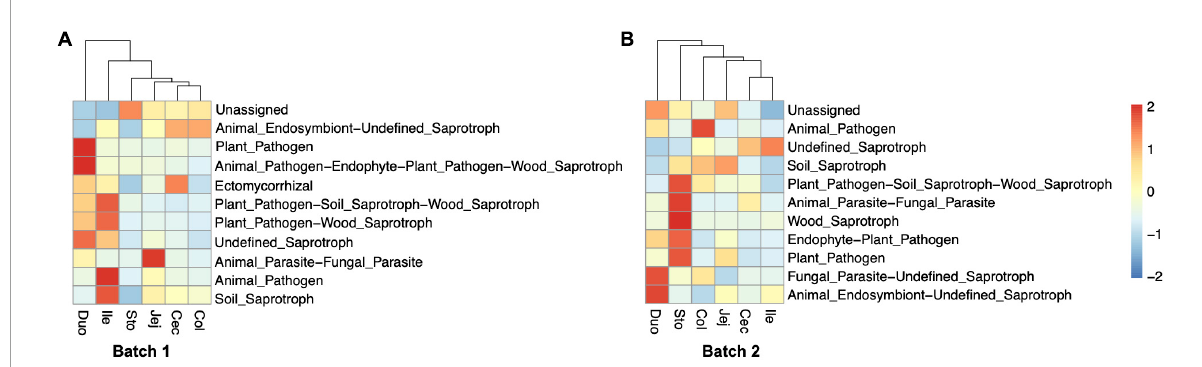
FIGURE6 Functional prediction of fungal community in different regions of the gastrointestinal tract in the pigs. Heatmap representing the relative abundance of predicted fungal functional guilds. Trophic guild assignments for fungal sequences were analyzed based on the FUNGuild database. (A) Bacth1, (B)